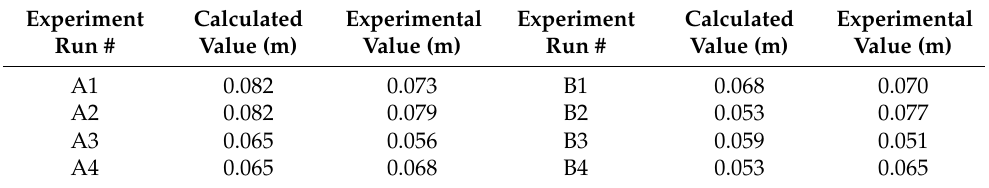
Table 2. Comparison of the calculated ice wave crest thickness to that of experiments.